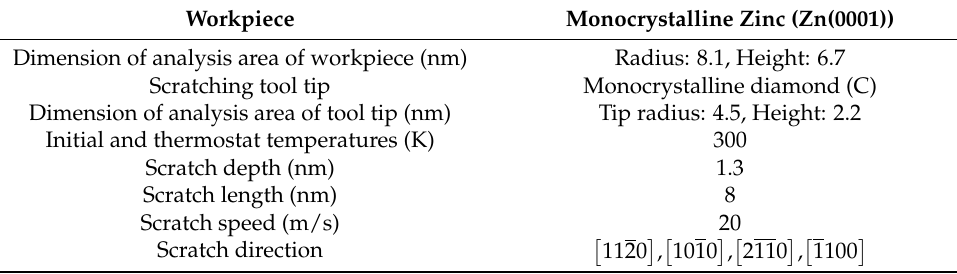
Table 5. Conditions for MD simulation of single groove nanoscratch. Workpiece Monocrystalline Zinc (Zn(0001)) Dimension of analysis area of workpiece (nm) Radius: 8.1, Height: 6.7 Scratching tool tip Monocrystalline diamond (C) Dimension of analysis area of tool tip